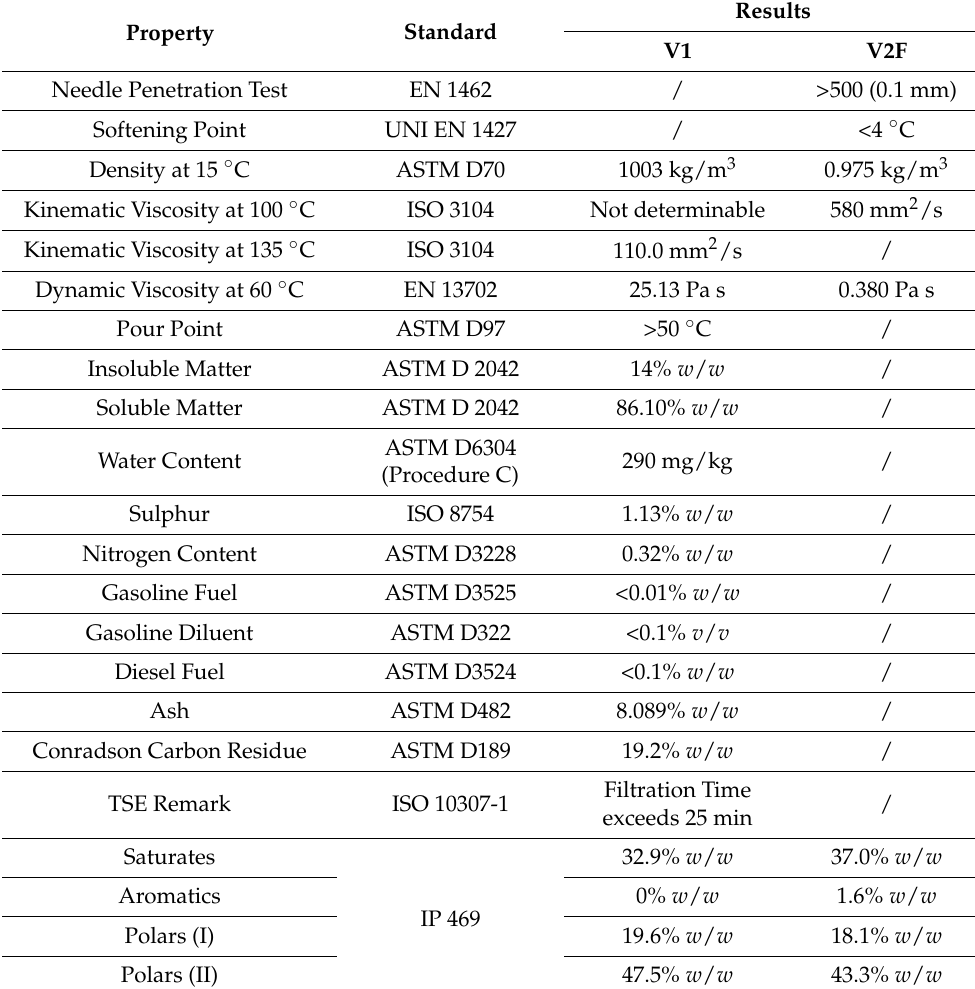
Table 1. Main physical and chemical characteristics of V1 and V2F.